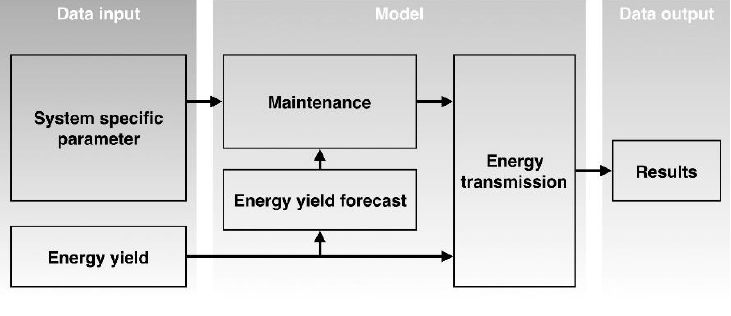
Figure 7. The overall model.